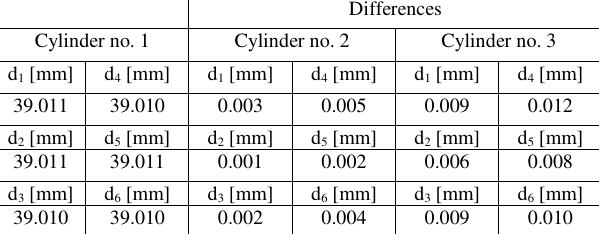
Table 3. Differences in diameter’s for nominal and worn cylinder